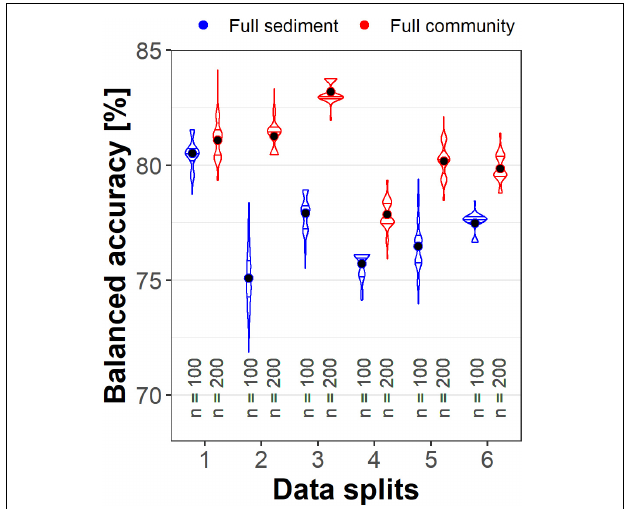
FIGURE 3 | Violin plots with median and interquartile range of correct TNT classifications for six different validation sets. Full community (red) always performed better than Full sediment (blue) and their performances changed independent of each other toward the different validation set compositions. The dot represents the mean balanced accuracy; n indicates the number of models